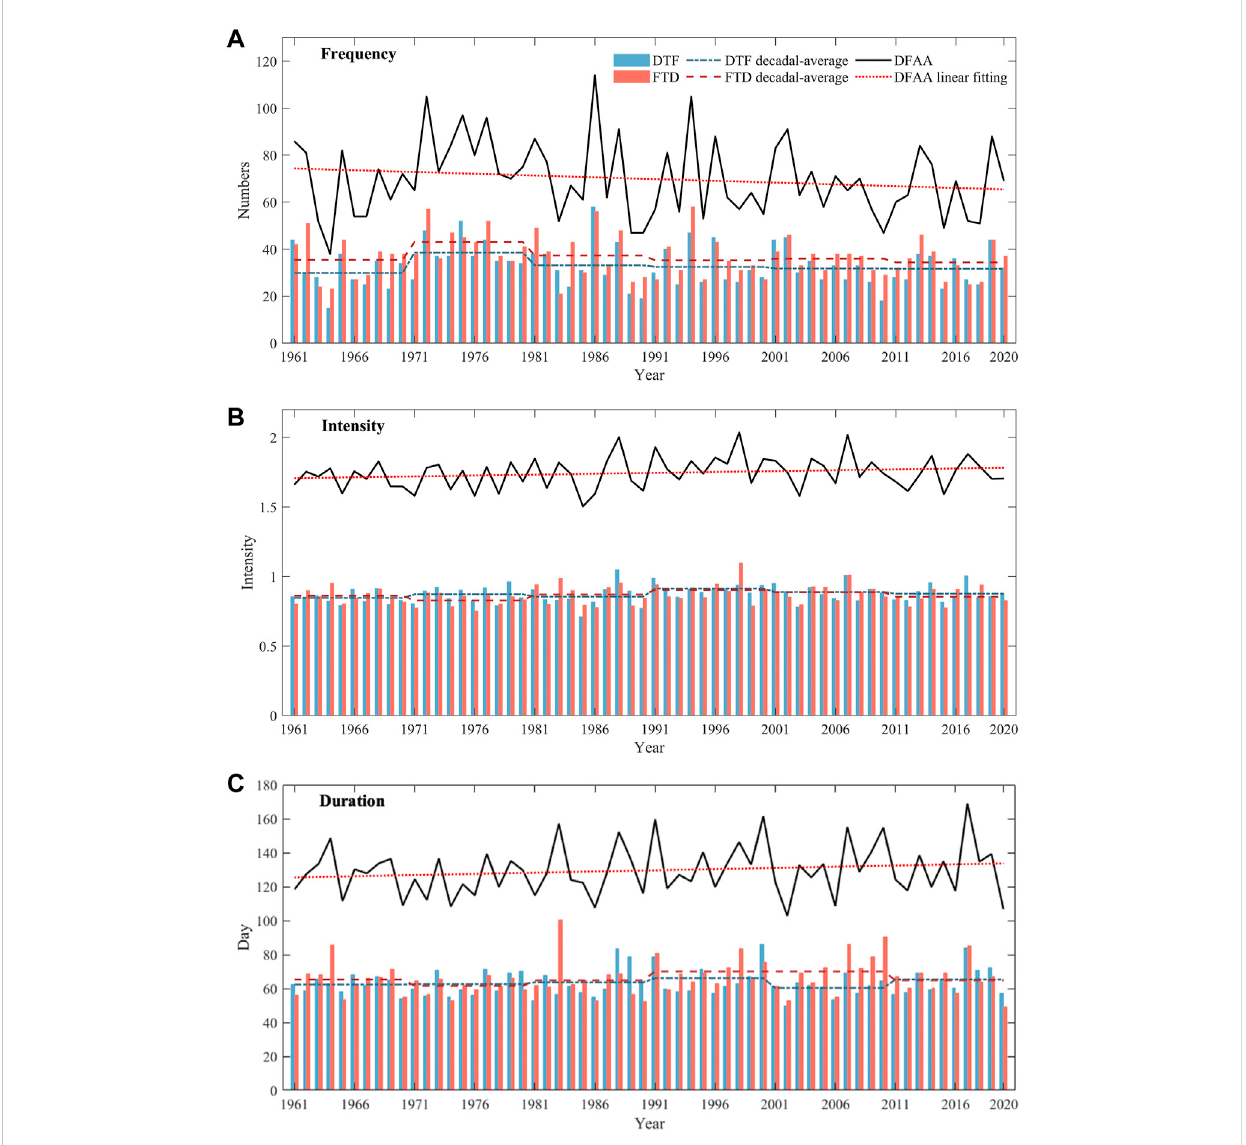
FIGURE 4 Characteristics of DTF, FTD, and DFAA events in the HRB between 1961 and 2020: (A) numbers, (B) intensity, and (C)